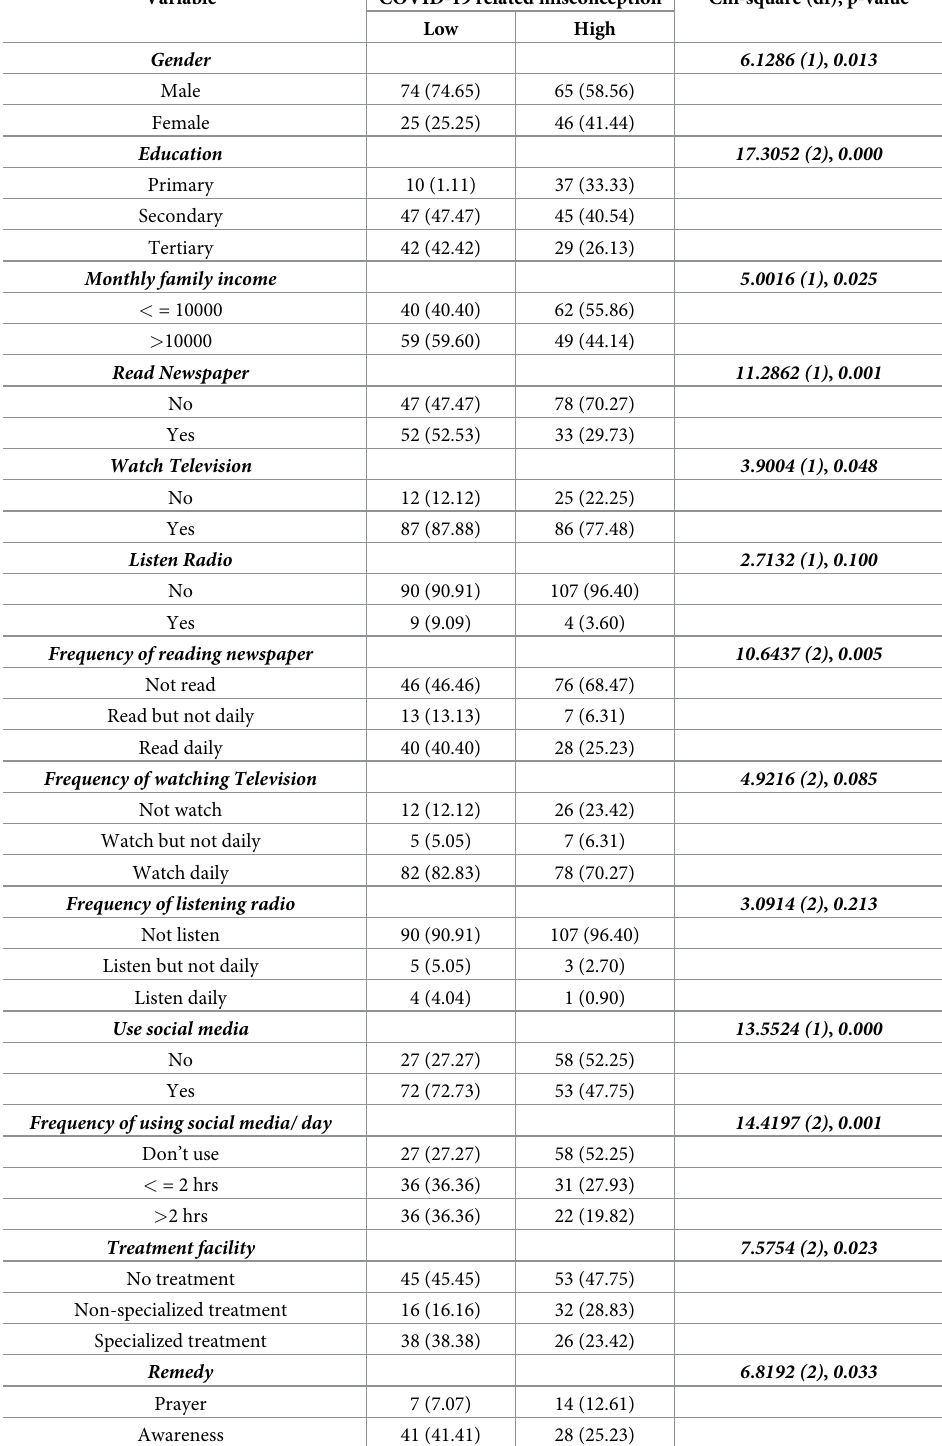
Table 3. Socio-demographic and media related variables among respondents with level of COVID-19 related mis- conception, Satkhira district- Bangladesh,